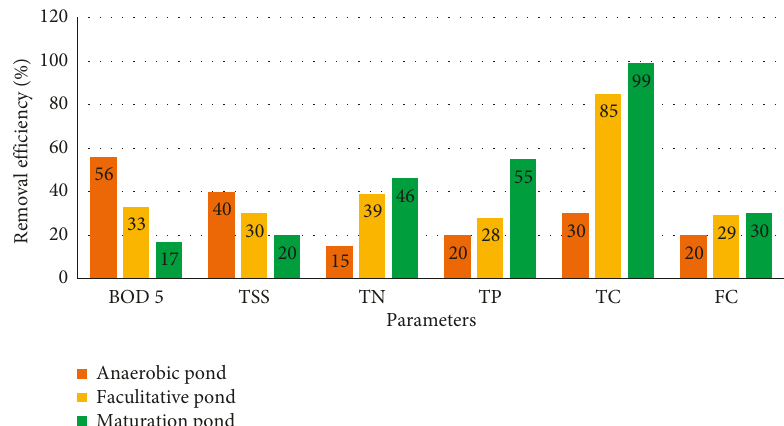
Figure 4: Removal efficiency of anaerobic, facultative, and maturation ponds using selected parameters in Kito Furdisa Campus, Jimma University, Jimma town, Southwest Ethiopia, 2020. Table 4: Water quality index of effluent of the WSP system in Kito Furdisa Campus, Jimma University, Jimma town, Southwest Ethiopia, 2020.